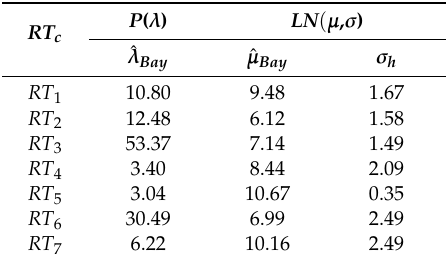
Table 11. The Bayesian estimators of parameters by risk category.